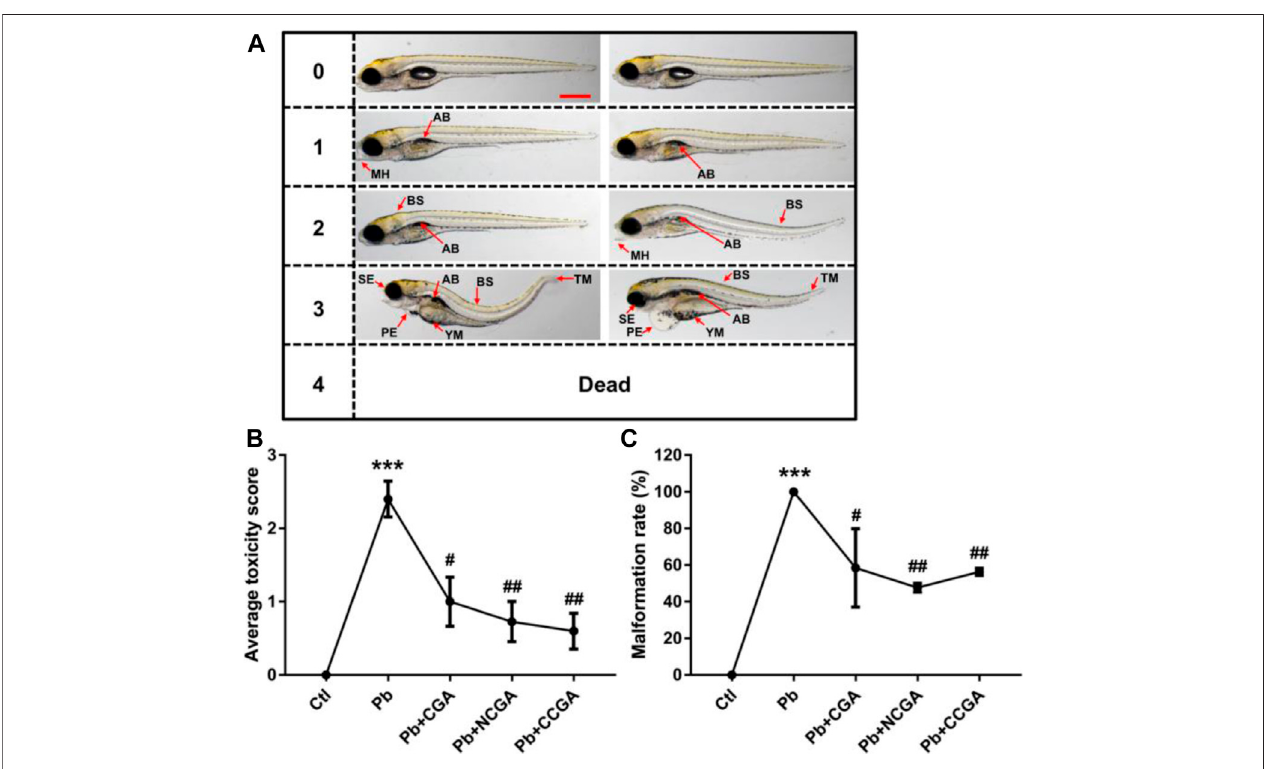
FIGURE2| Micrographs,averagetoxicityscores,andmalformationrate. (A) Representativeimagesoftoxicityscorefrom0to4 at120 hpf.Zebra fi shmalformation was scored from level 0 to level 4.0, zebra fi sh developed normally; 1 – 3, zebra fi sh had slight-to-severe defects; 4, embryonic lethality. Two images for each of semiquantitative toxicityscoringindicatethatbothoftheseabnormalitiesarerankedasthesametoxicityscore(scalebar,500 μ m). (B) Averagetoxicityscoreat120 hpf ( n (cid:1) 6); *** p < 0.001 vs. control and # p < 0.05, ## p < 0.01 vs. Pb. (C) Pb-induced phenotypic defects and malformation rate ( n (cid:1) 15); *** p < 0.001 vs. control and # p < 0.05, ## p < 0.01 vs.